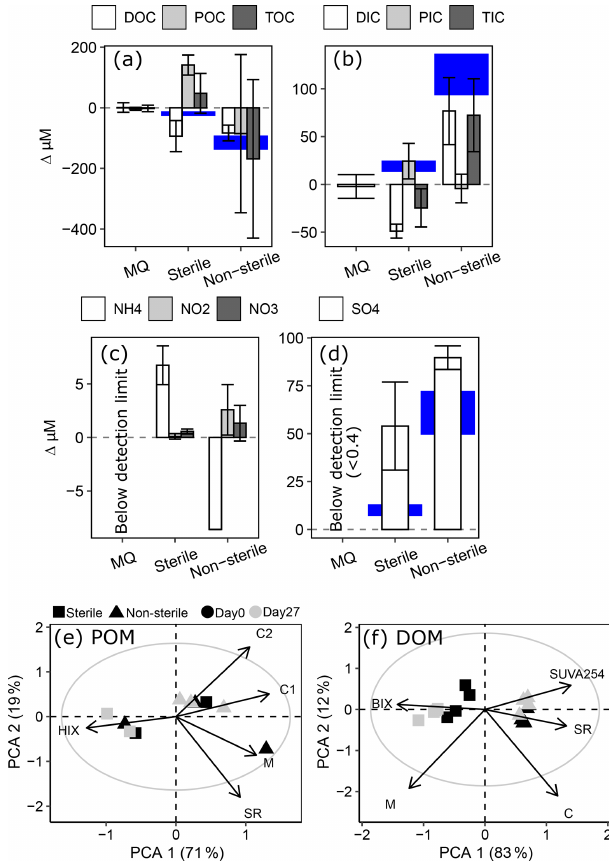
Figure 5. Changes in millimolar concentrations of (a) organic car- bon; (b) inorganic carbon; (c) ammonium (NH + ), nitrite (NO − ), 4 2 and nitrate (NO − ); and (d) sulfate (SO 2 − ) in 2019 test of interfer- 3 4 ences. Note difference in scales between panels. Blue shading high- lights potential carbon gains or losses based on O 2 loss and a respi- ratory quotient of 1 (a–b) and potential SO 2 − generated from pyrite 4 oxidation ( d ; Eq. 3). Error bars and height of blue shading both show a range representing 95% confidence intervals. (e–f) PCA biplots of components 1 and 2 showing variation in POM (e) and DOM (f) optical properties. Grey circle outlines circle of equilib- rium contribution, and plot is shown in scaling 1. Abbreviations of optical indices are provided in Table